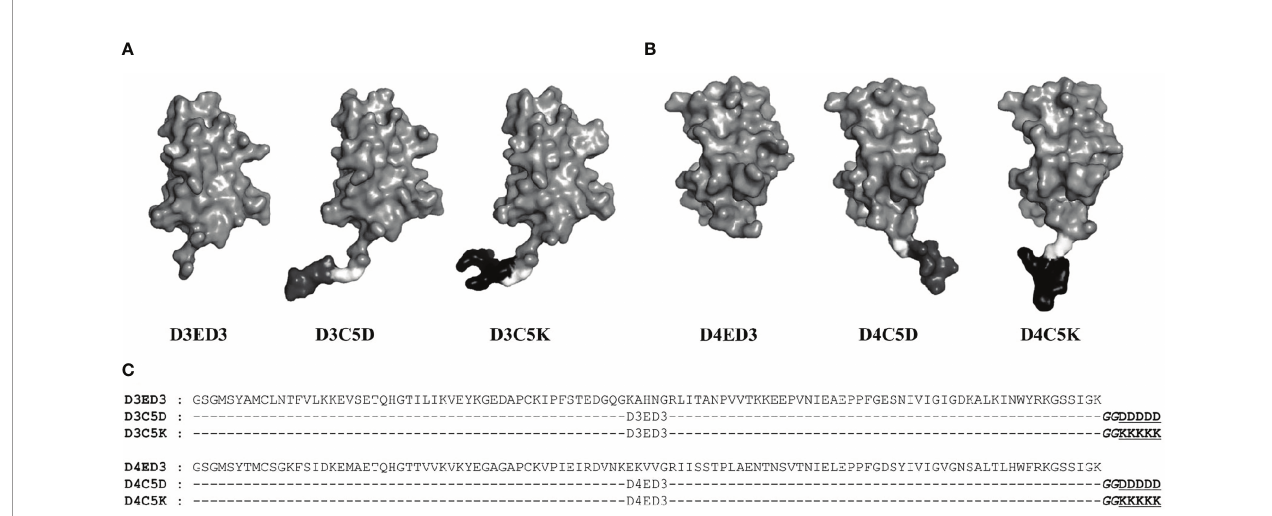
FIGURE 1 | Sequences and schematic structures of the SCP-tagged ED3 variants. Surface models of the tagged (A) D3ED3 and (B) D4ED3 variants generated using the crystal structures of 3ED3 (3vtt.pdb) (50) and 4ED3 (3we1.pdb) (23) respectively, as templates. In short, we added the tag residues to the template structures using COOT (51) and MODELLER, assuming that the backbone structures remain unchanged. The pictures were generated using PyMOL (52). Glycine spacer is shown in light grey, the Aspartic and Lysine tags are shown in dark grey and black, respectively. (C) The sequences of D3ED3 and D4ED3 were obtained from UniProt (37,38). The 5-residue SCP-tag sequence, attached at the C-terminus of D3ED3 or D4ED3, is underlined and consists of two Glycines (italic), used as a spacer between the host protein and the